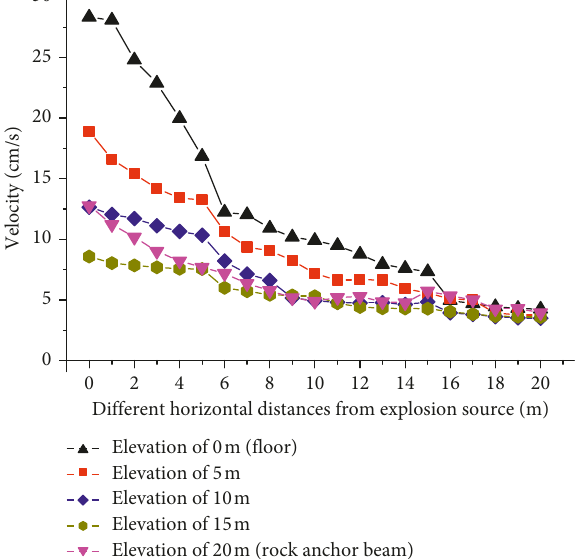
Figure 10: Distribution curve of vibration velocity along horizontal distance at different